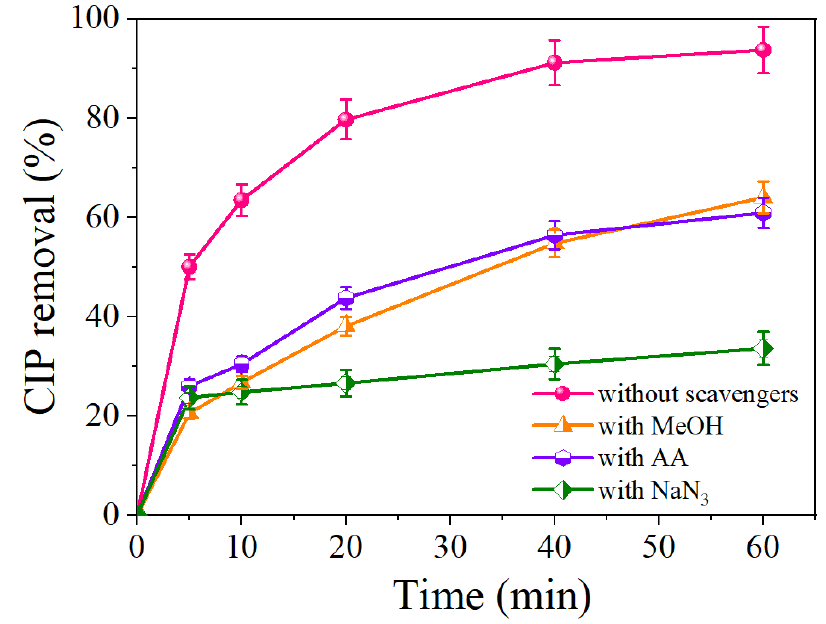
Figure 5. CIP degradation in presence of various radical scavengers.